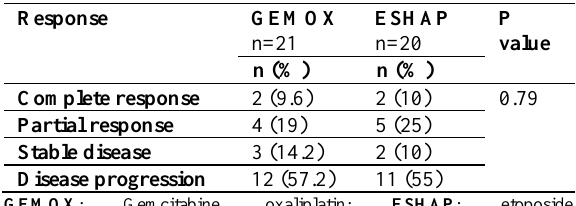
Table 2. Response to GEMOX and ESHAP